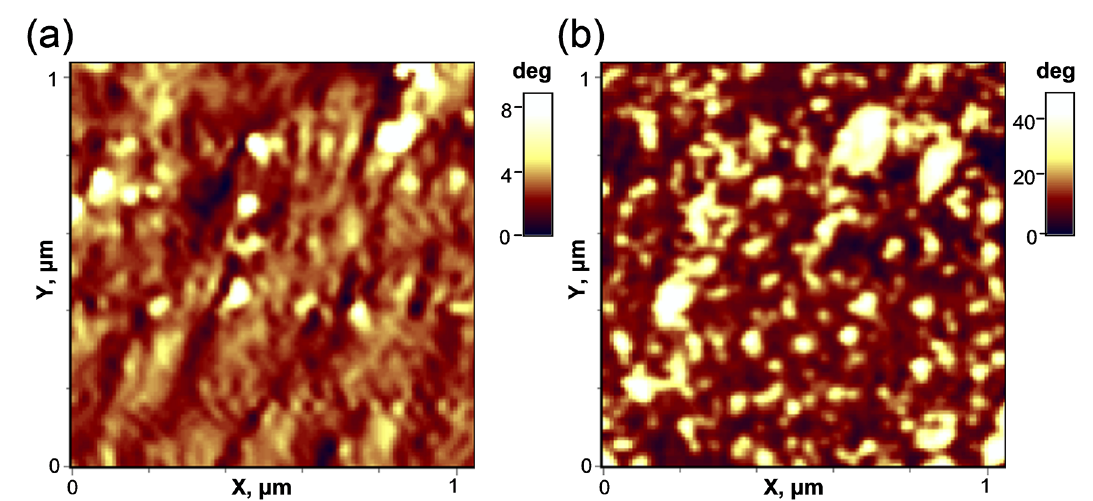
Figure 2. AFM phase images of (a) untreated and (b) sulfuric acid treated PEDOT:PSS+DMSO single-layer films